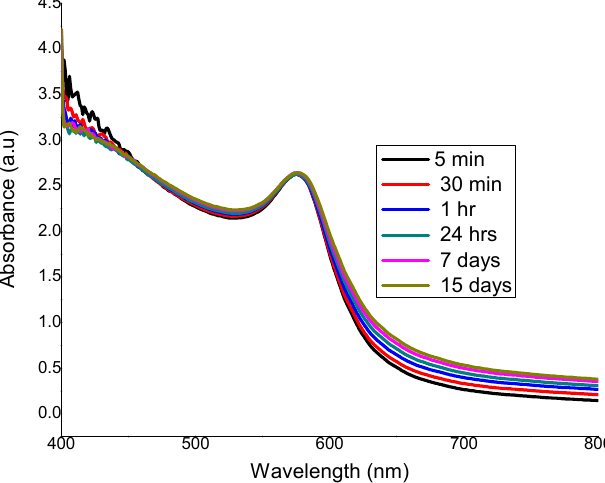
Figure 1. Time-dependent study of Rano-Cu NPs solution showing stability profile for a period of two weeks.